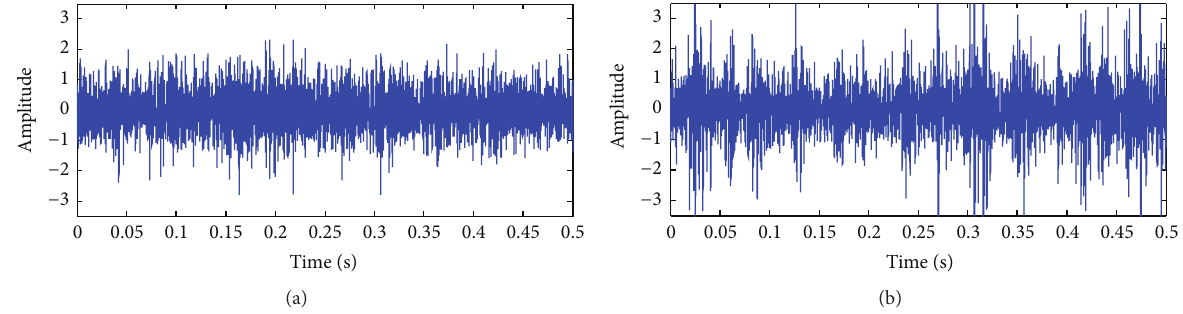
Figure 7: Time-domain signal. (a) Normal gear; (b) faulty gear.